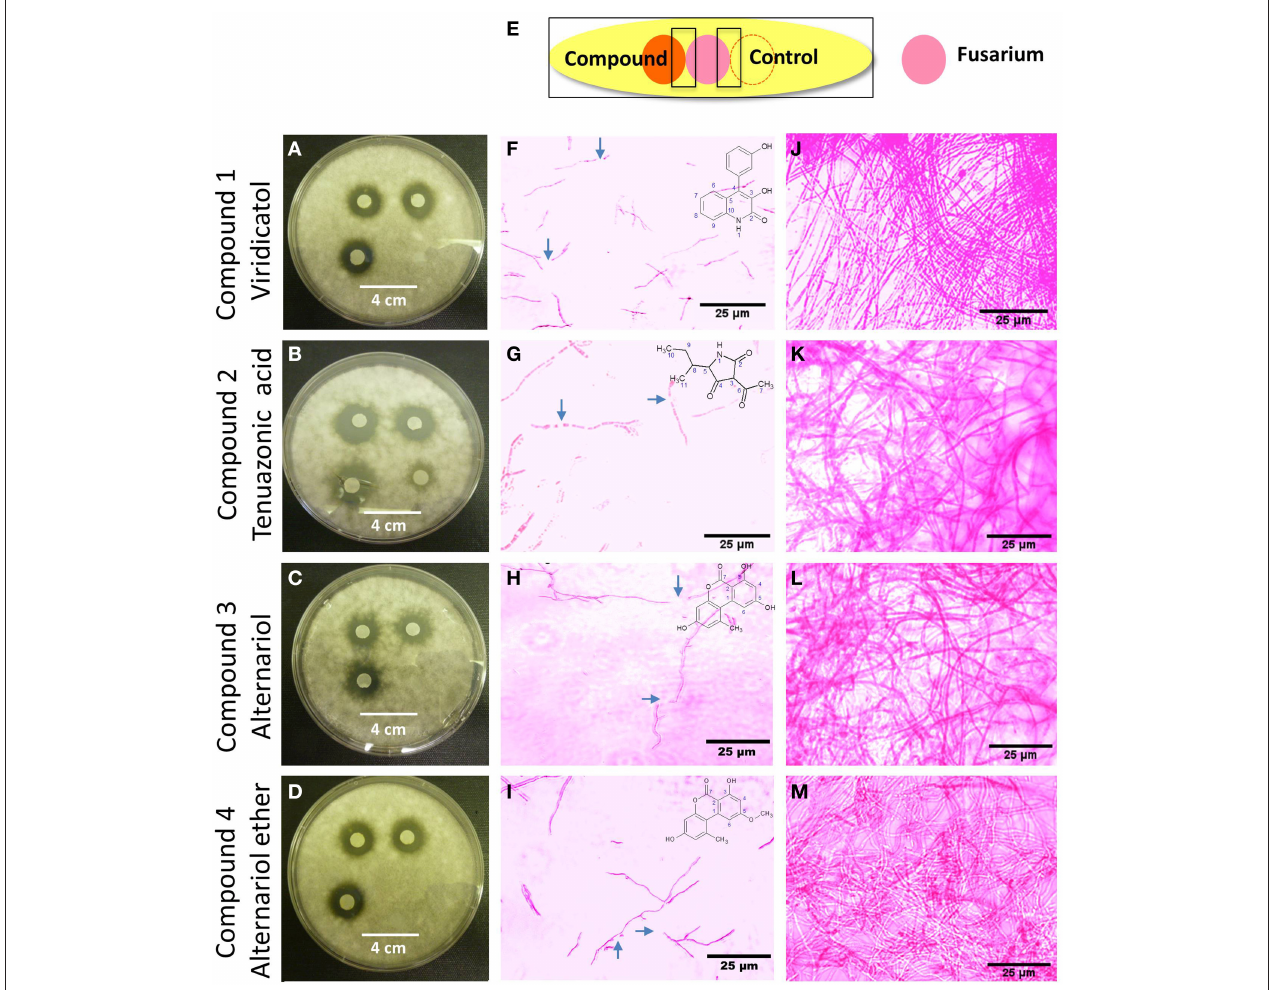
FIGURE 7 | The effects of the purified compounds on F. graminearum in vitro using the agar disc diffusion assay and neutral red staining. (A–D) Representative pictures of the agar disc diffusion assay of the purified anti-fungal compounds, (A) viridicatol, (B) tenuazonic acid, (C) alternariol, and (D) alternariol monomethyl ether ( n = 3 ). The inhibition of F. graminearum is shown by the clear halo around each disc soaked with the purified compound. (E) Cartoon of the experimental methodology to examine microscopic in vitro interactions between F. graminearum (pink) and each compound (orange) or the buffer control (respective compound solvent). The microscope slides were pre-coated with PDA and incubated for 24h. F. graminearum hyphae were then stained with the vitality stain, neutral red. Shown are representative microscope slide pictures ( n = 3 ) of the interactions of F. graminearum with: (F) viridicatol compared to (J) the buffer control; (G) tenuazonic acid compared to (K) the buffer control; (H) alternariol compared to (L) the buffer control; (I) alternariol monomethyl ether compared to (M) the buffer control. The blue arrows point to areas of apparent breakage of F. graminearum